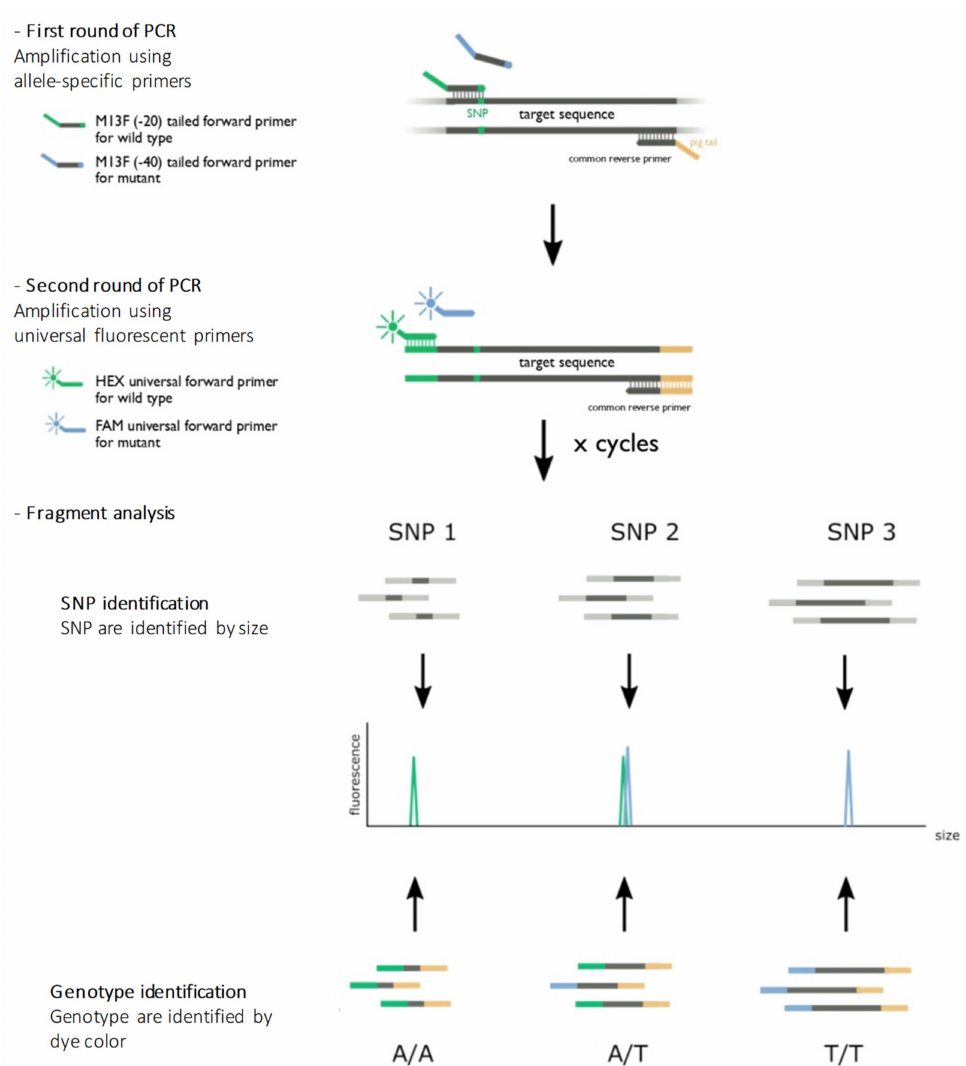
Figure 3. Principle of the assay. The first round of amplification used allele-specific primers designed to obtain di ff erent fragment sizes for each genetic location. The last nucleotide of the 3 (cid:48) flanking forward primers was specific to the genotype (wild-type or variant allele). The reverse primer was the same for both alleles (wild type or variant allele). A pigtail GTTTCTT was added to the 5 (cid:48) flanking reverse primers to improve the amplicon migration. A second round of amplification used universal primers combined with fluorescent probes. An M13 sequence (-20) GTAAAACGACGGCCAGT in the 5 (cid:48) flanking forward wild-type primers allowed the hybridization and amplification of the wild-type allele, and an M13 sequence (-40) GTTTTCCCAGTCACGAC in the 5 (cid:48) flanking forward variant primers allowed the hybridization and amplification of the variant allele. After denaturation, PCR products were loaded on a sequencer. The color of the fluorescence of the fragment allowed allelic discrimination, and the size of the fragment allowed genetic position